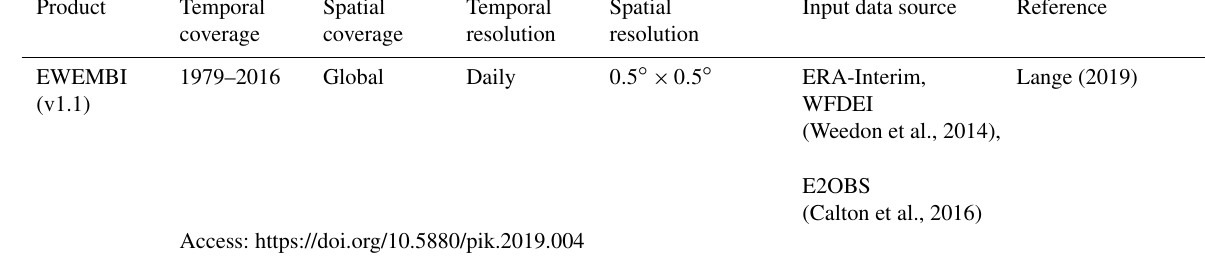
Table 3. Characteristics of precipitation products. Product